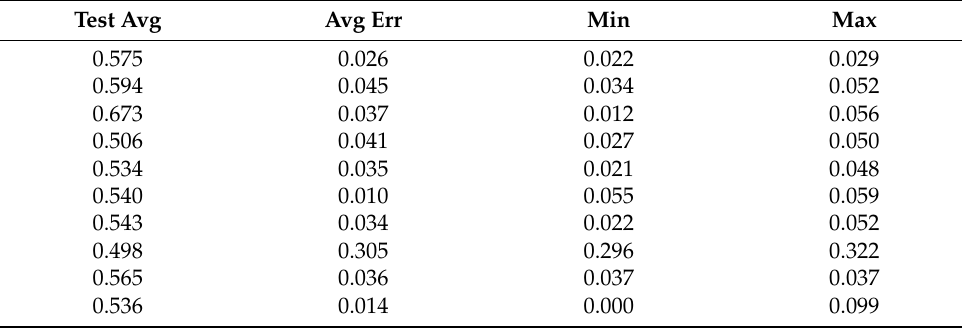
Table A148. Set 2, trials 41–50 data (average actual PR